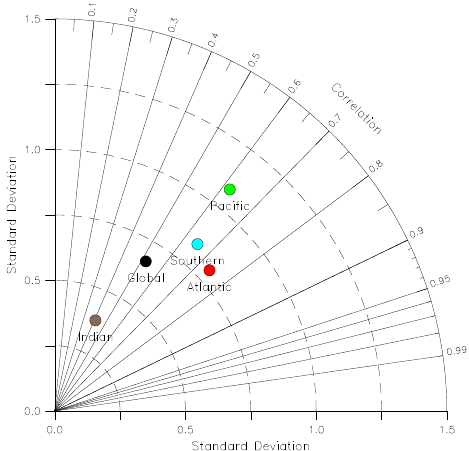
Figure 15. Taylor diagram of model–observation comparisons for mesozooplankton using monthly mean fields. Data come from the Green Ocean Project web site. Black dot corresponds to the global ocean; red dot to the Atlantic Ocean, green dot to the Pacific Ocean, brown dot to the Indian Ocean and gray dot to the Southern Ocean (south of 45 ◦ S).